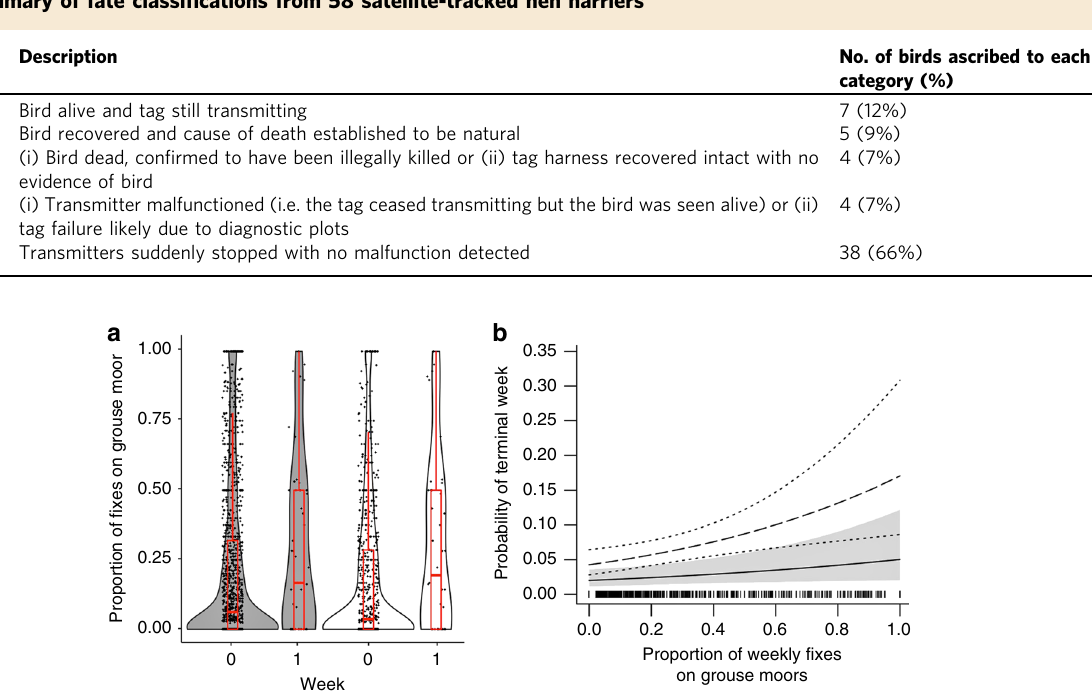
Fig. 1 Use of grouse moors in relation to terminal weeks. a The density distribution and data spread for the weekly proportion of fi xes on grouse moors during live weeks (0) and terminal weeks (1) for all tracked hen harriers (grey shaded, n = 58 individuals) and for harriers known to have been illegally killed (I) combined with those which had tags that suddenly stopped with no indication of a malfunction (SNM) (white, n = 42 individuals). Box plots (red) show the median, upper and lower quartile and whiskers (1.5× interquartile range). b The effect of grouse moor use on the probability of it being a terminal week (i.e. the probability of death or disappearance). Solid line represents all harriers with con fi dence intervals (CIs) shaded grey; dashed line represent I and SNM harriers only, with CIs shown by dotted lines. Source data are provided as a Source Data fi le